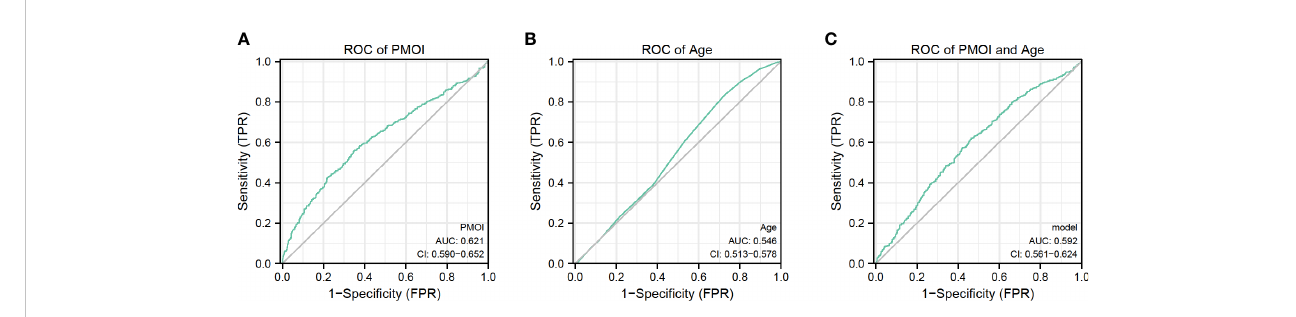
FIGURE 2 Predictive value of PMOI and age for pregnancy outcomes.